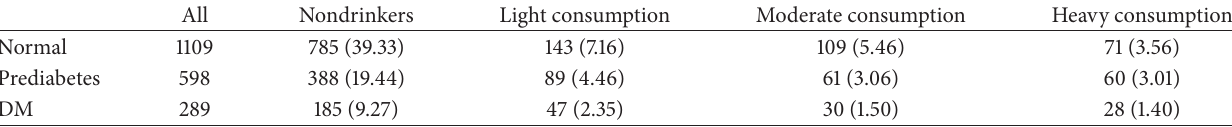
Table 2: The incidence of newly diagnosed diabetes and prediabetes in the drinkers and nondrinkers (%).